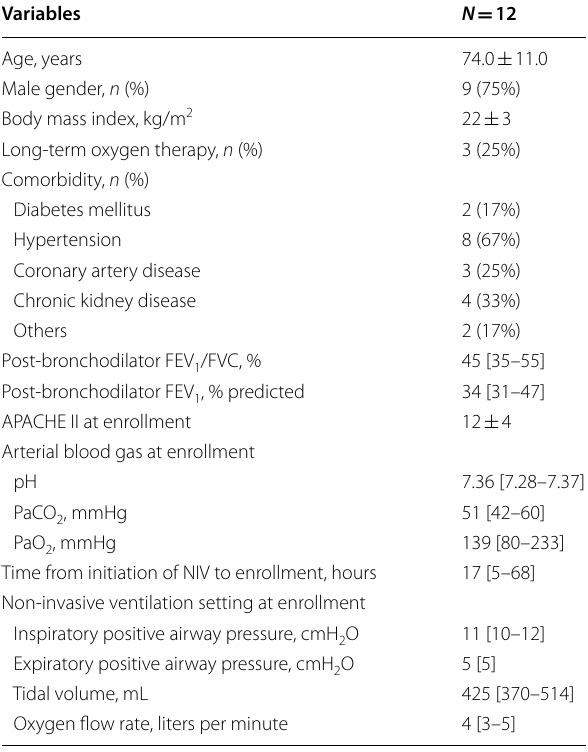
Table 1 Baseline patient and